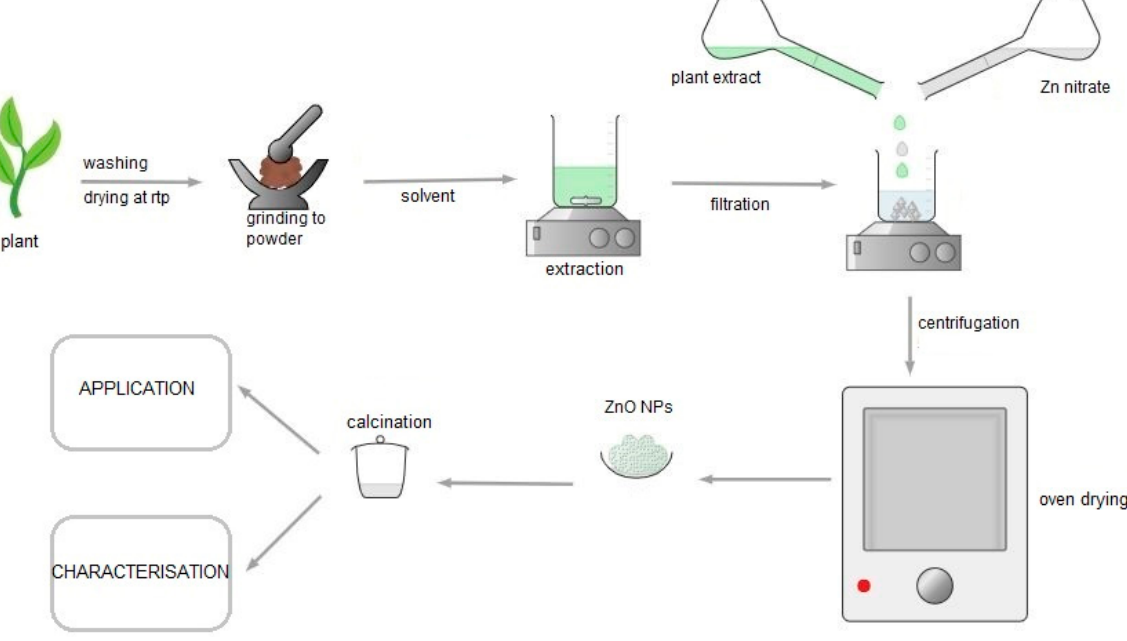
Figure 4. Schematic of the most common ZnO NPs synthesis